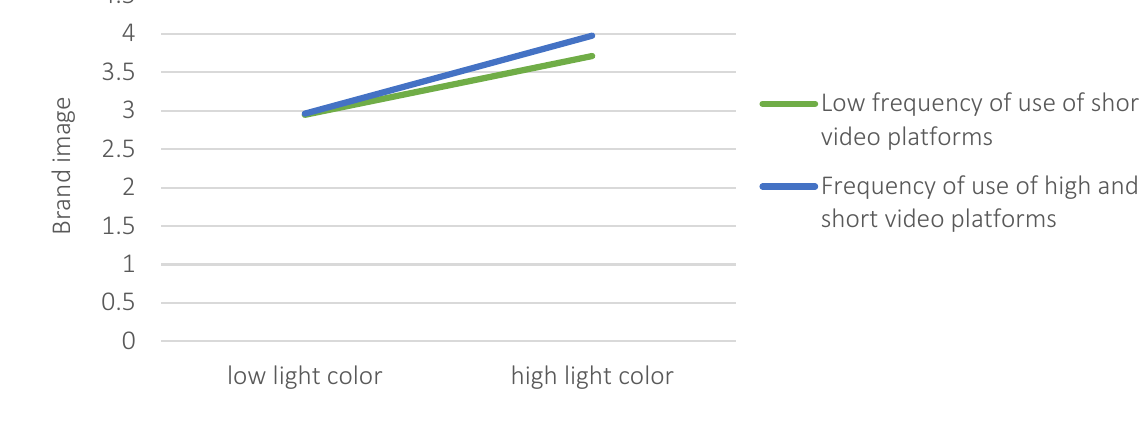
Figure 1. Line chart of moderating